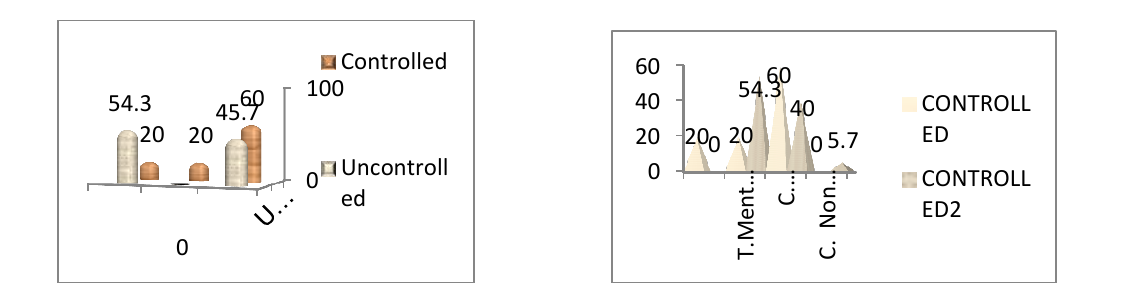
 2 : Chi square test MCp: p for Monte Carlo test